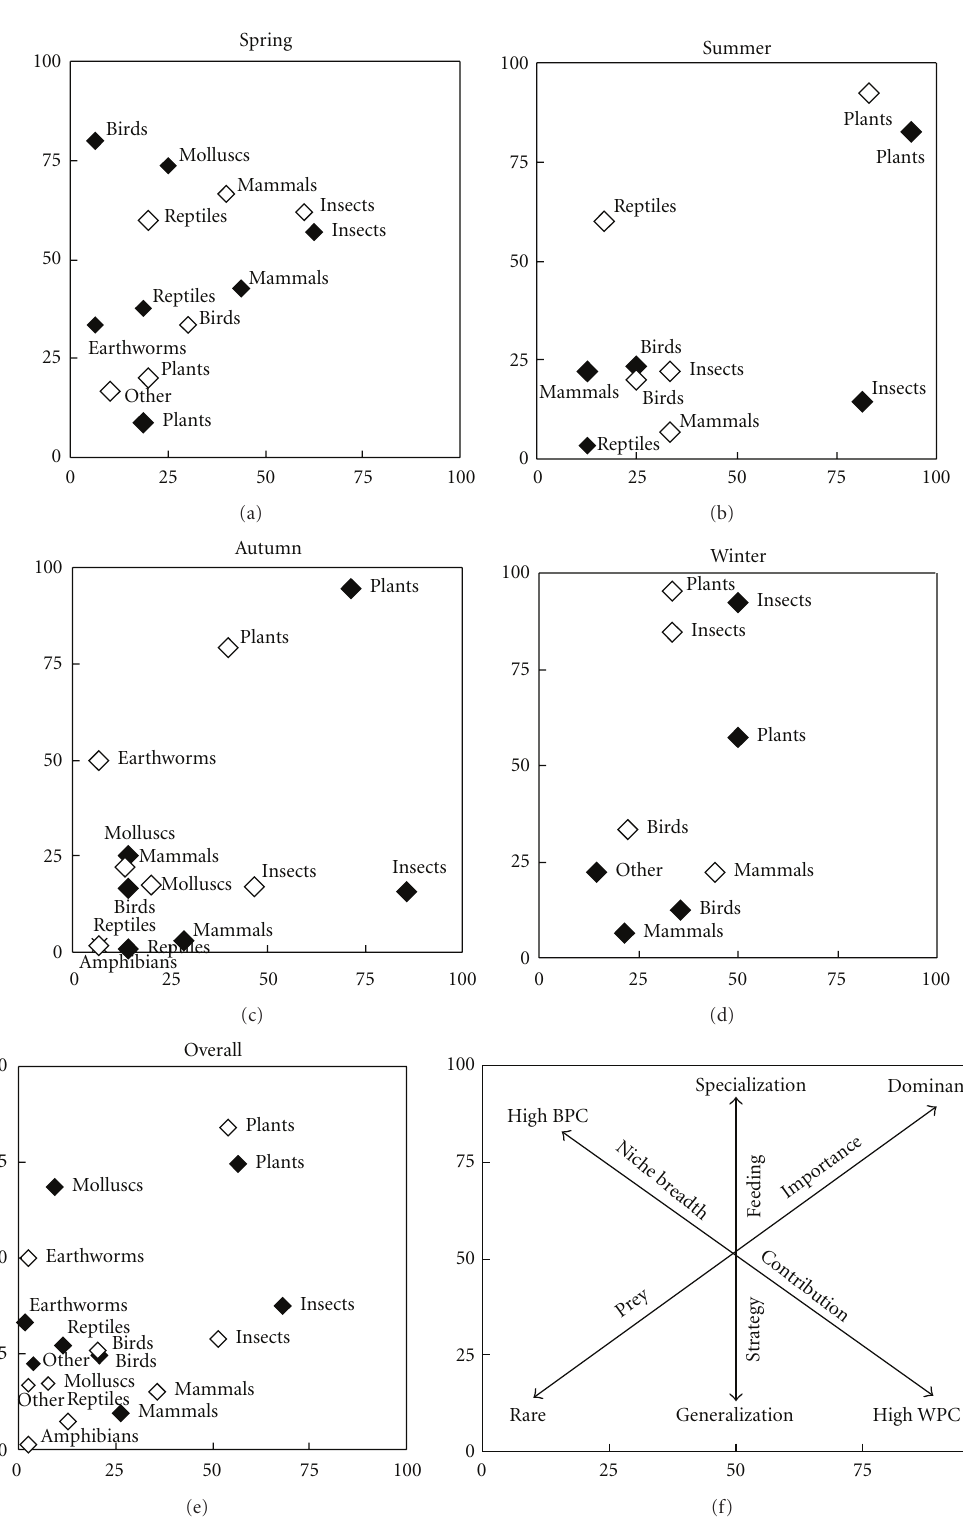
Figure 2: Seasonal (a)–(d) and overall (e) feeding strategy of the male (filled symbols) and the female (open symbols) stone martens in Central Greece, (f) graph redrawn from Amundsen et al. [29]. X -axis represents %F (frequency of occurrence), and Y -axis %P (prey-specific